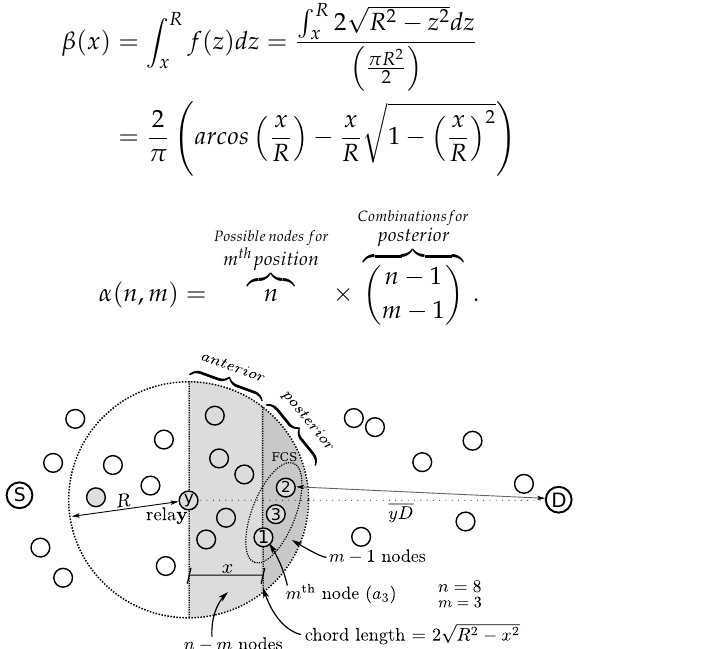
Figure 4. Example of calculation of the average advancement for forwarding candidate set (FCS) cardinality of